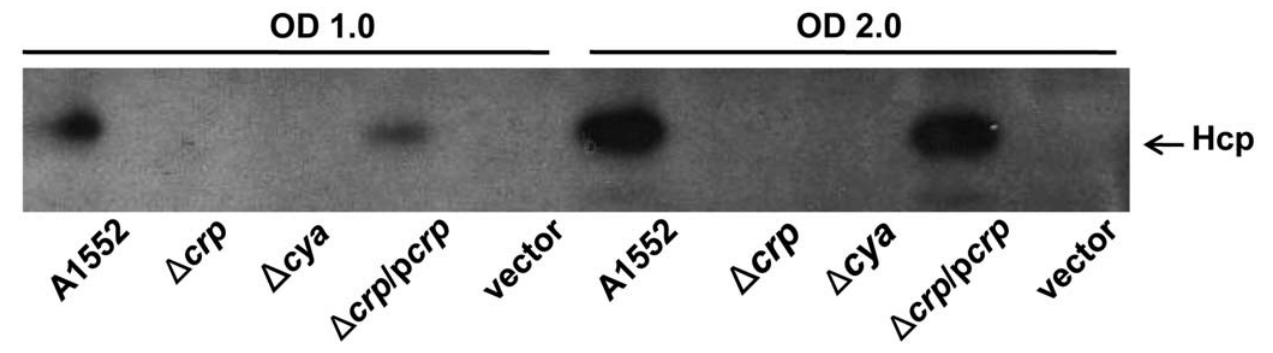
Figure 5. Hcp levels in D crp and D cya mutants of V.cholerae strain 1552. Immunoblot analysis of Hcp levels in whole cell lysates of V. cholerae O1 wild type strain A1552, D crp , D cya , D crp /p crp , and D crp /vector control strains. The whole cell lysates were taken at OD 1.0 and OD 2.0 and immunoblot was done using anti-Hcp antiserum.